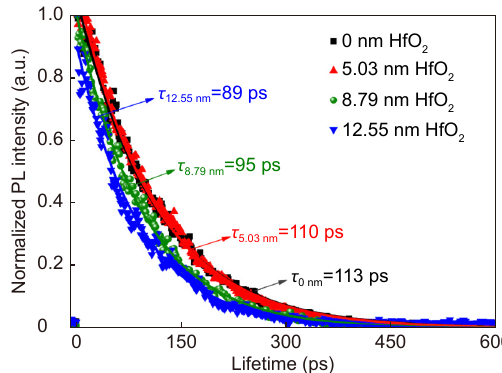
Fig. 4 | The lifetime of ZnO MW on various substrates with excit- ation power of 8 μW